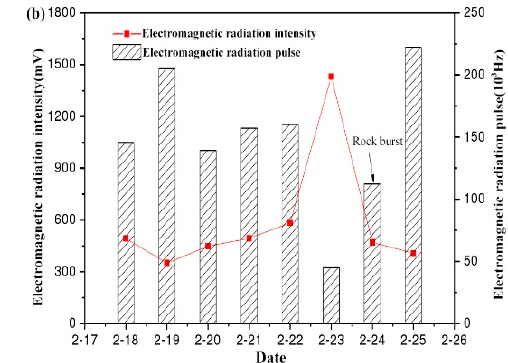
Figure 7. EMR and AE rule of rockburst disaster on 24 February 2014: ( a ) AE ( b ) EMR.